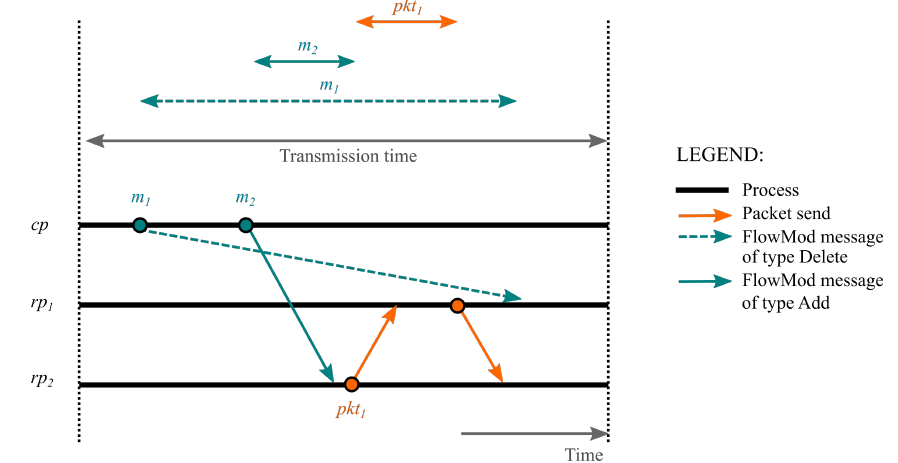
Figure 3. The communication diagram corresponding to Figure